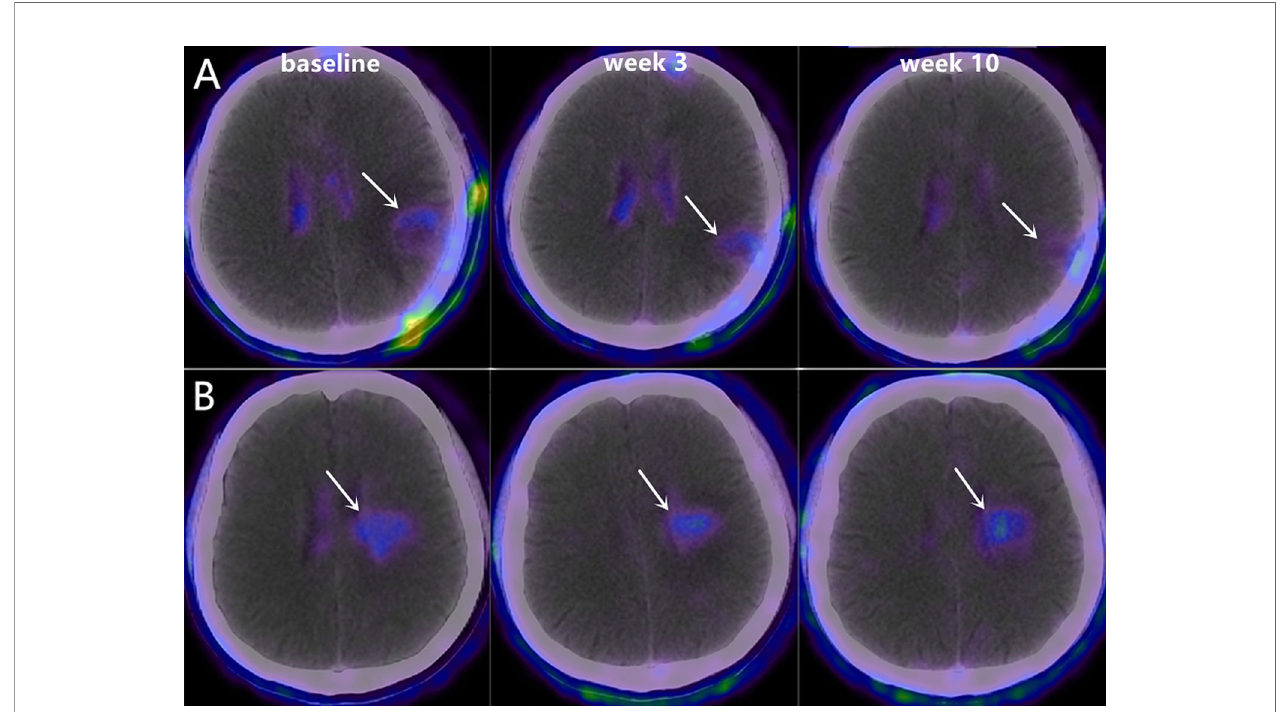
FIGURE 3 | Representative 18 F-RGD PET/CT scans at baseline, week 3 and week 10 in two patients with PFS of 9.65 months ( A , Male, 48 years old, decrease in SUV mean =-0.45) and 7.45 months ( B , Male, 62 years old, decrease in SUV mean =0.25).